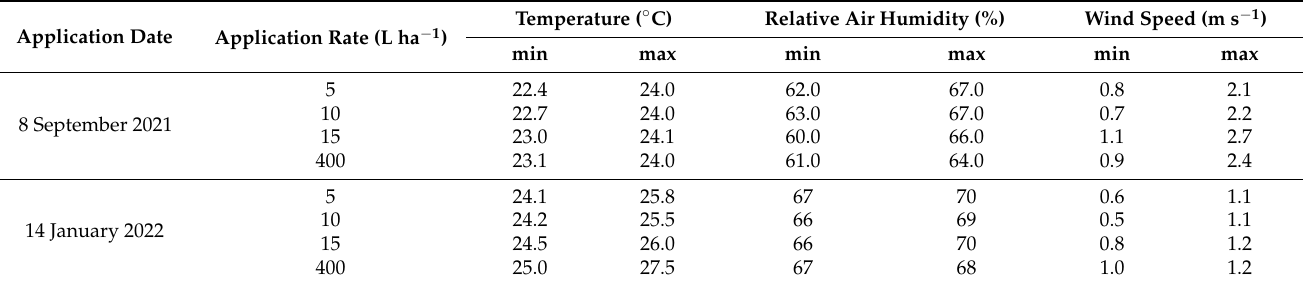
Table 3. Climate conditions during the pesticide applications.